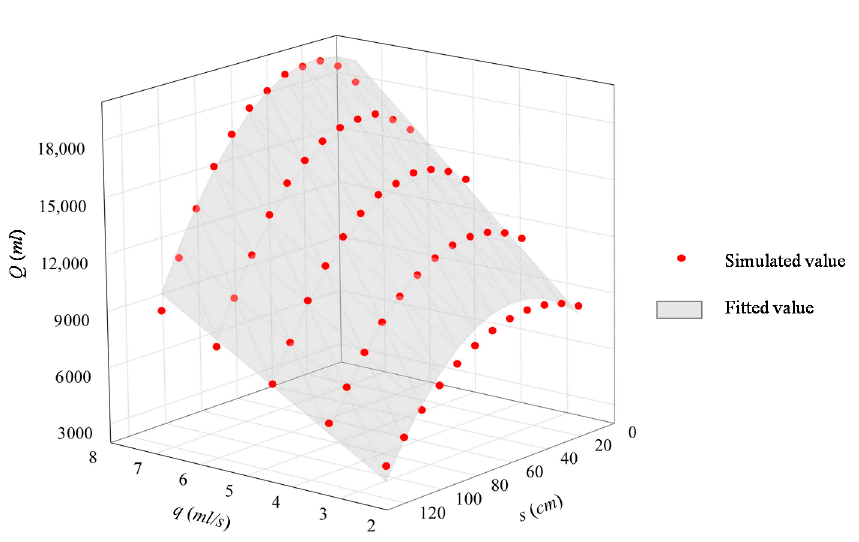
Figure 15. Q max binomial regression model.